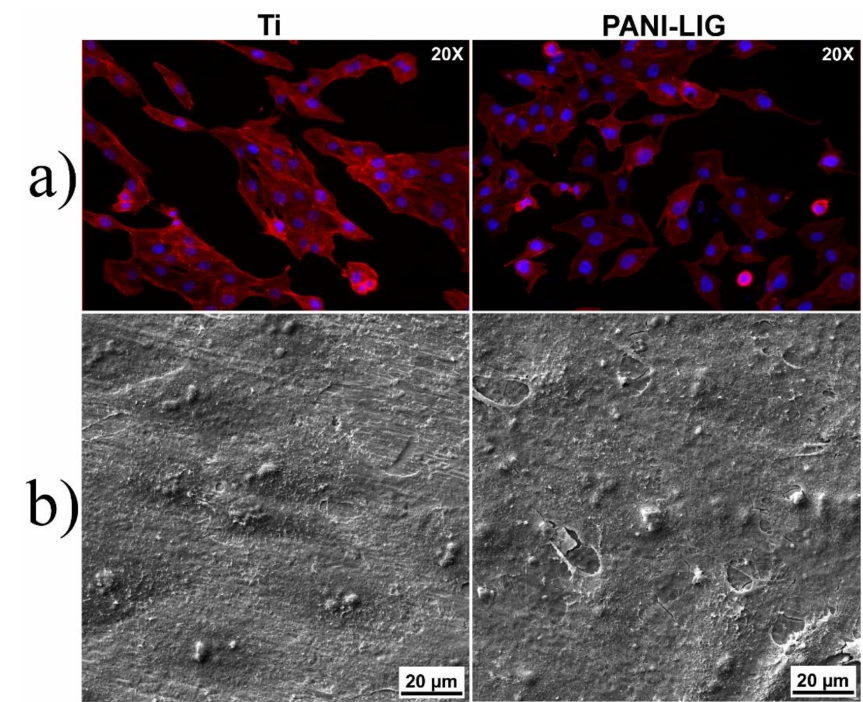
Figure 7. MG-63 cells fluorescence microscopy for substrate and PANI-LIG coatings (red Phalloidin & Hoechst staining) ( a ) and SEM images of MG-63 cells treated in the presence for substrate and PANI-LIG coatings at 48 h of incubation ( b ). (For interpretation of the references to color in this Figure legend, the reader is referred to the web version of this article.).